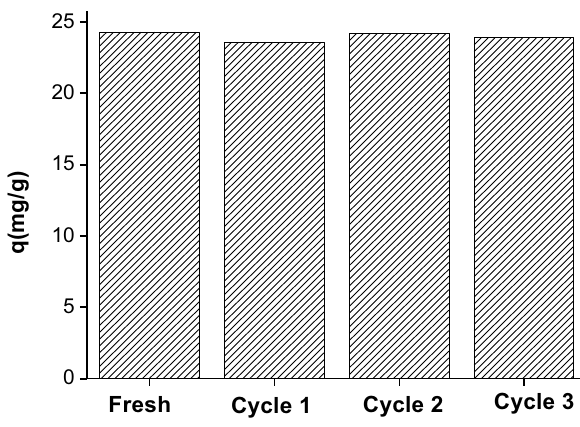
Fig. 10 Adsorption of Pb(II) by DES/H tion of the co-cations in solution (Time = 120 min, pH = 5, Temp. = 25 ± 2 °C)